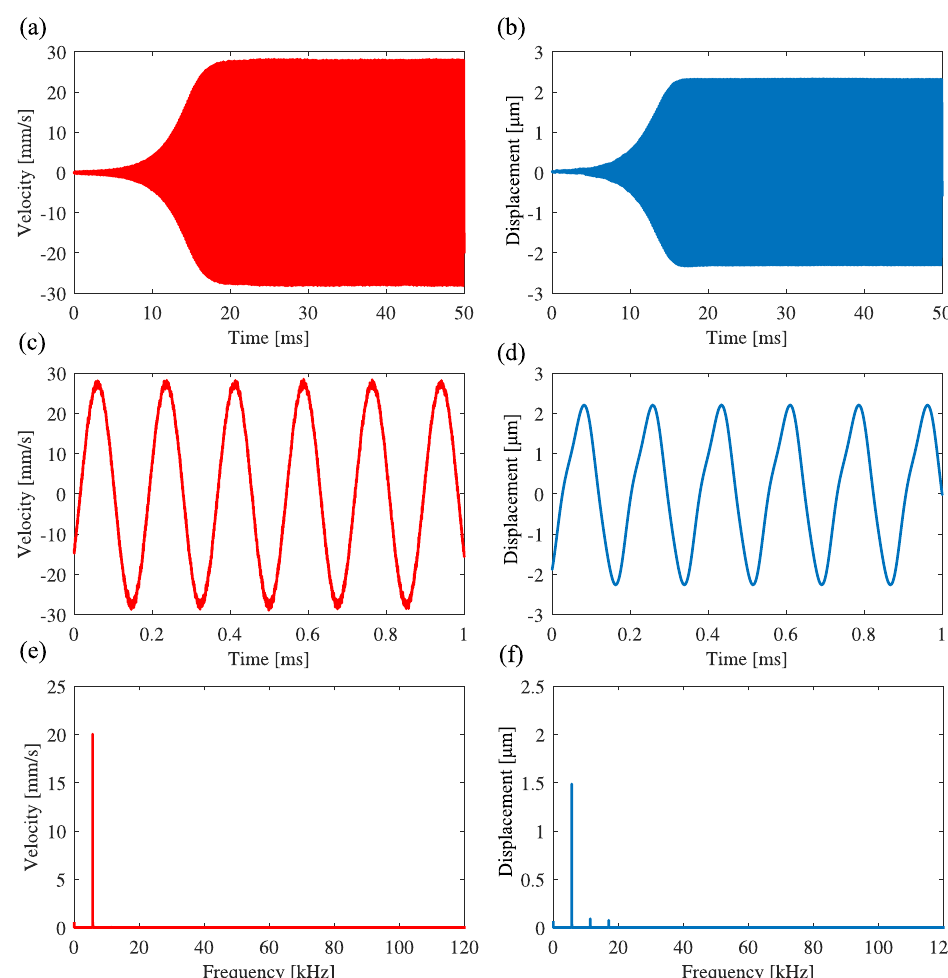
Figure 7. Self-excited oscillation with first mode under feedback control in the case without band-pass filtering: g 1 = − 2.5, g 3 = 50. ( a , b ) are the time histories of the cantilever and the control signal to the piezoelectric actuator. ( c , d ) are the expansions of ( a , b ) in the steady state, respectively. ( e , f ) are the FFT analysis for the oscillation of the beam and the excitation displacement,